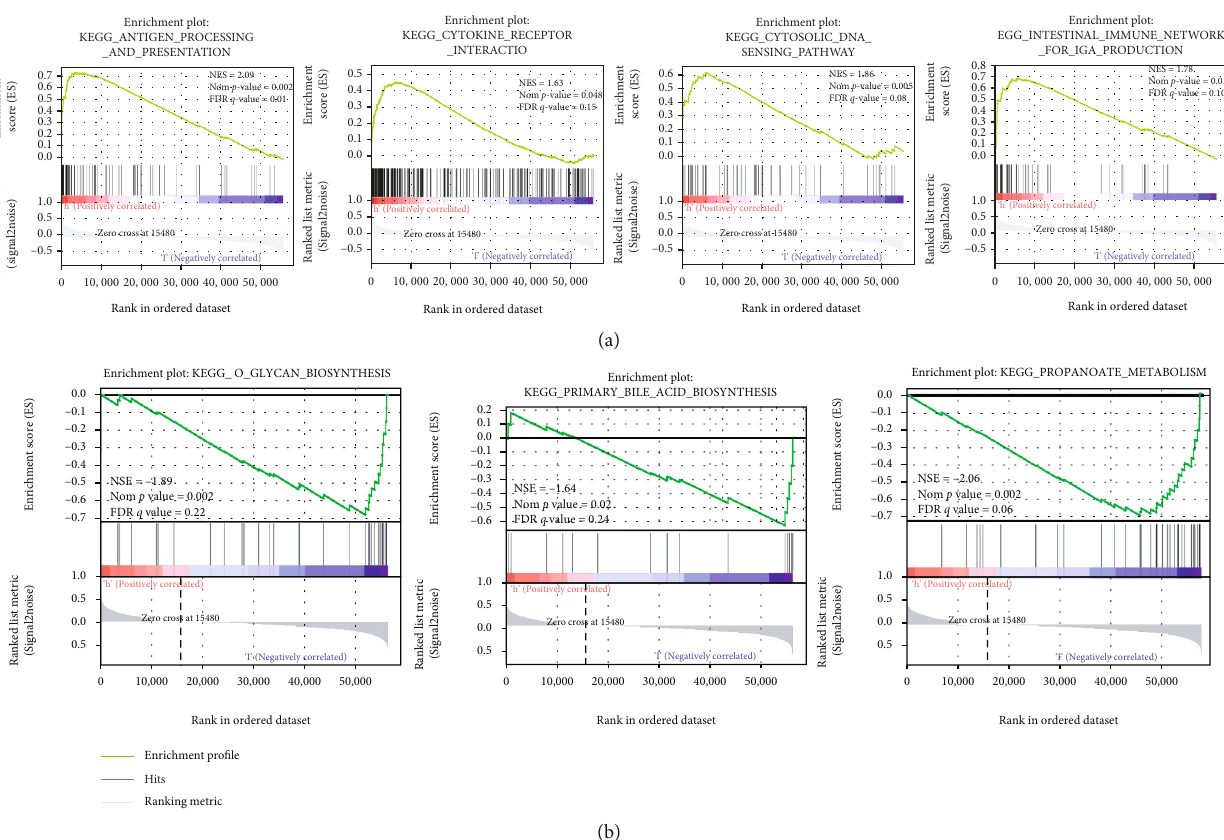
Figure 3: GSEA. (a) The major enriched pathways for the high-expression group. (b) The primary enriched pathways for the low- expression